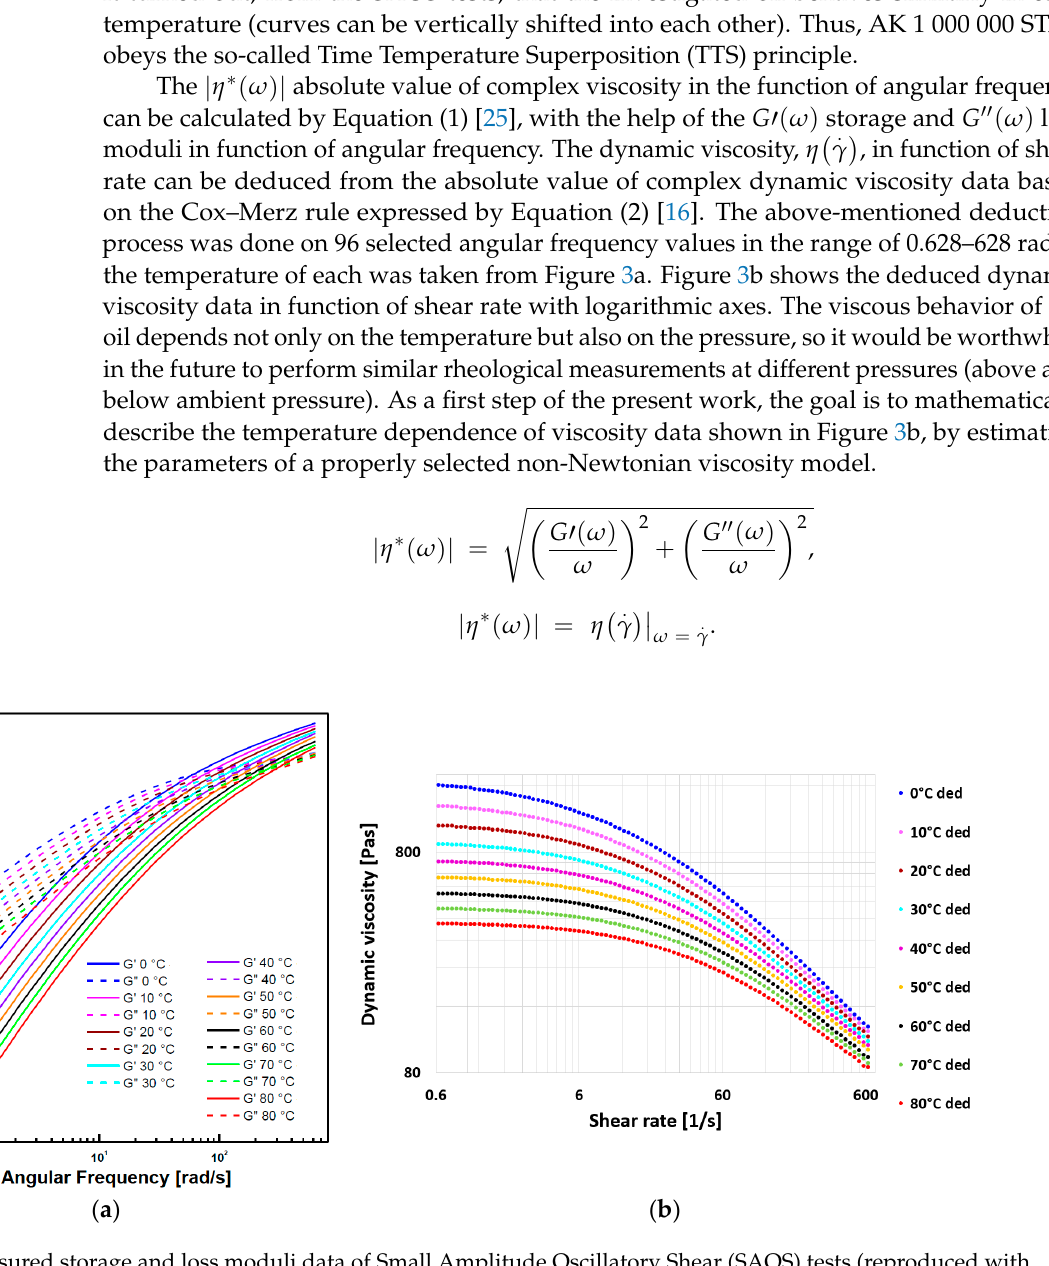
Figure 3. ( a ) Measured storage and loss moduli data of Small Amplitude Oscillatory Shear (SAOS) tests (reproduced with permission from Z. K˝okuti [13]. ( b ) Deduced dynamic viscosity data in 96 selected shear rates, at each temperature. The geometric standard deviation was calculated for each storage and loss moduli curve obtained from rheological measurement at each investigated temperature (see Table